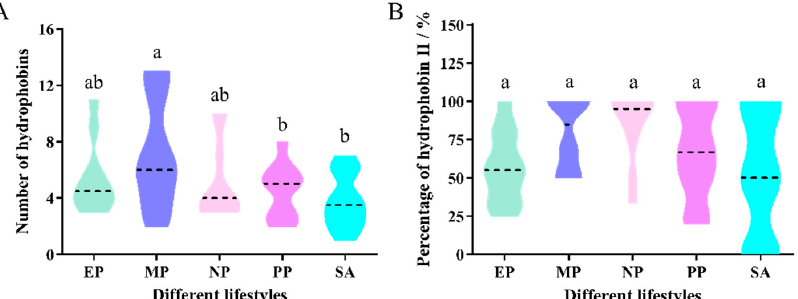
Figure 1. Distribution of hydrophobins in Ascomycota fungi with different lifestyles. ( A ) Number of hydrophobins in Ascomycota fungi with different lifestyles; ( B ) Percentage of class II hydrophobins in Ascomycota fungi with different lifestyles. EP, Entomopathogenic fungi; MP, Mycoparasite; NP, Nematode parasitic fungi; PP, Plant pathogenic fungi; SA, Saprotrophic fungi. The black dotted line represents the median. The different letters over the violin indicate the significant difference at p = 0.05.